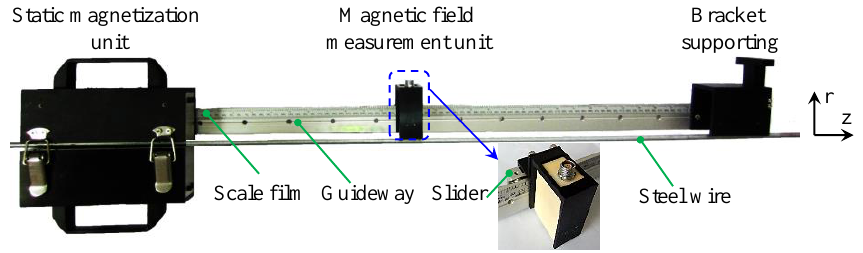
Figure 8. The assembly of the proposed sensor.